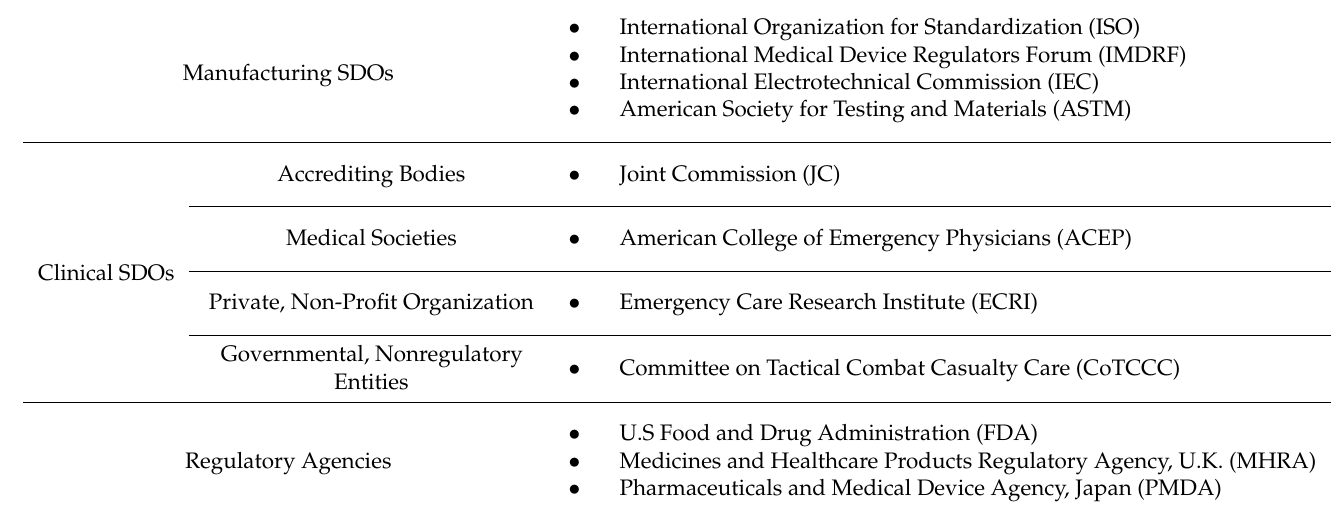
Table 1. Standards developing organizations (SDOs) with examples relevant to suction